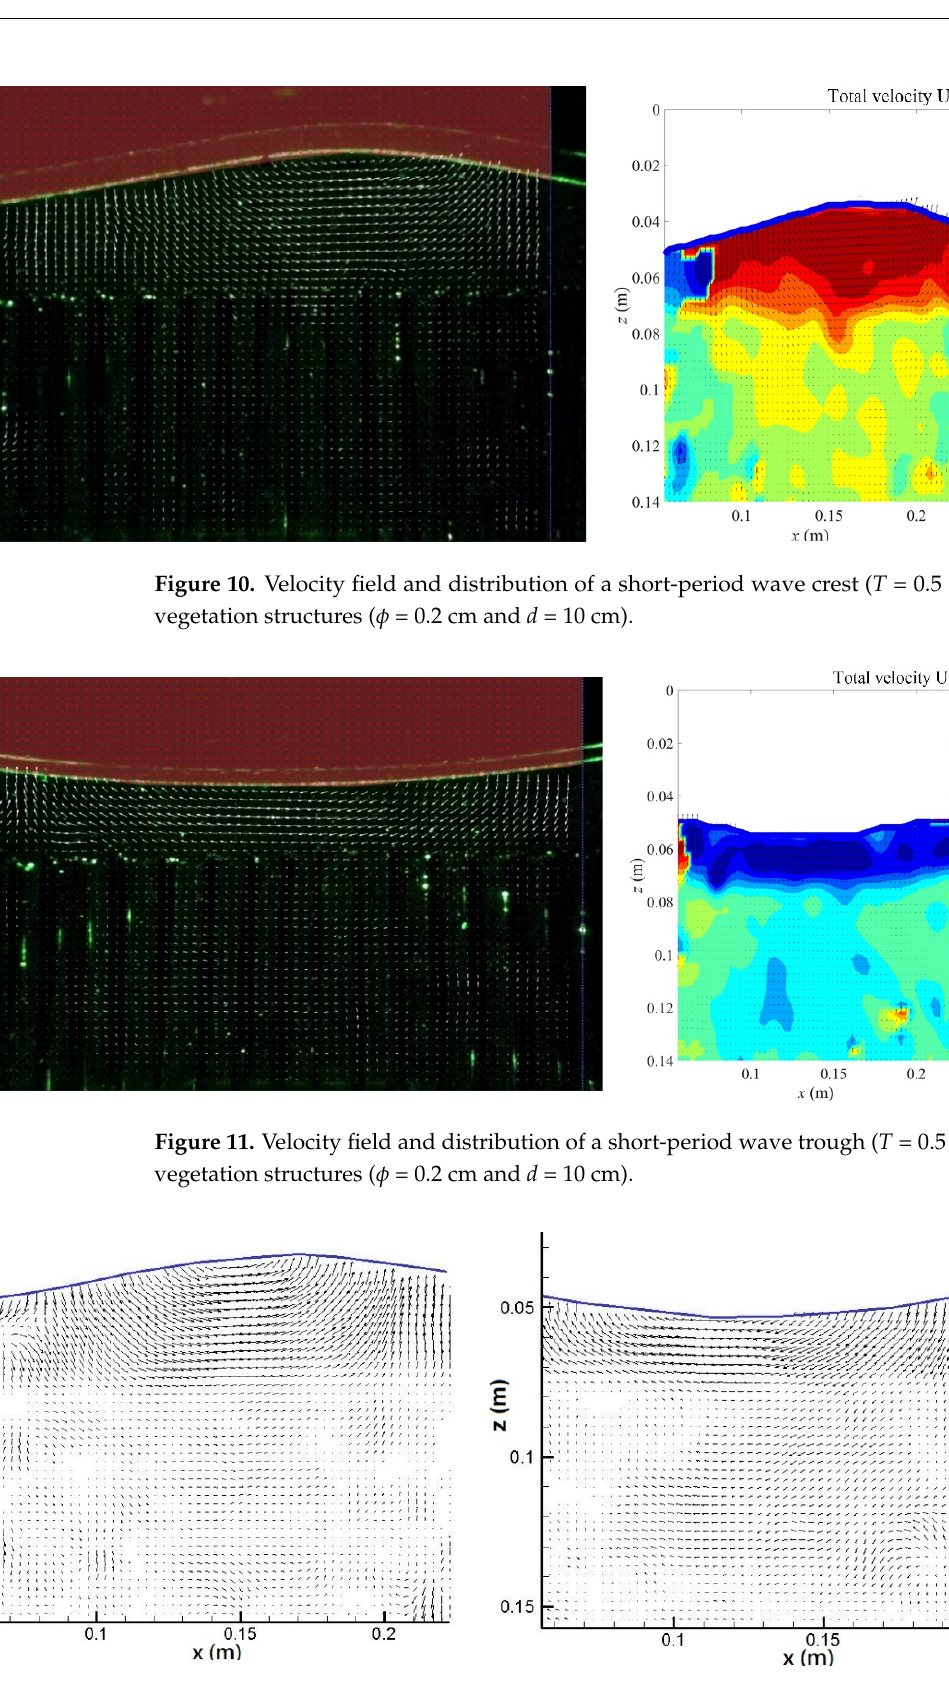
Figure 12. Velocity distribution of a short-period wave ( T = 0.5 s) around vegetation region ( ϕ = 0.2 cm and d = 10 cm).